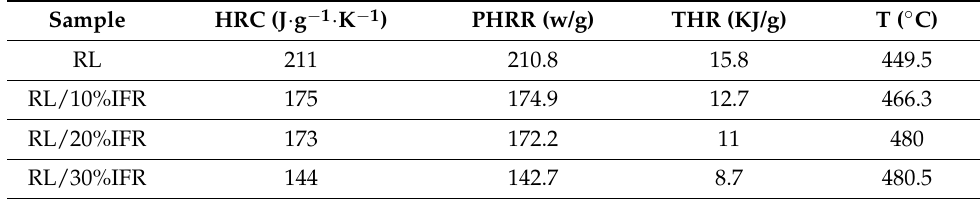
Table 2. MCC test analysis of lacquer films with different FR content.